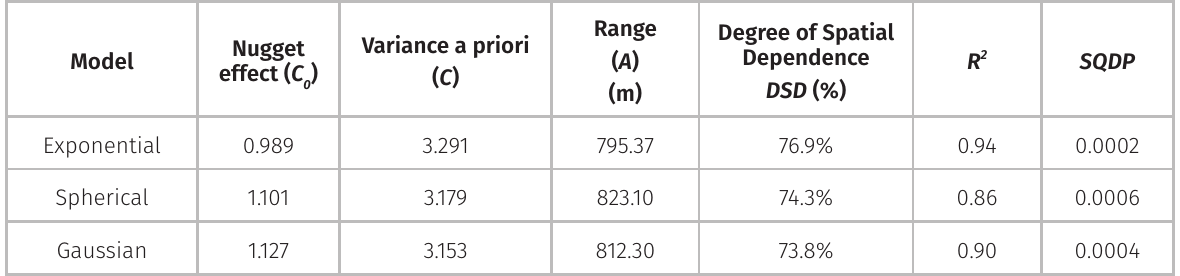
at the age of reference for Eucalyptus sp. in a tropical dom